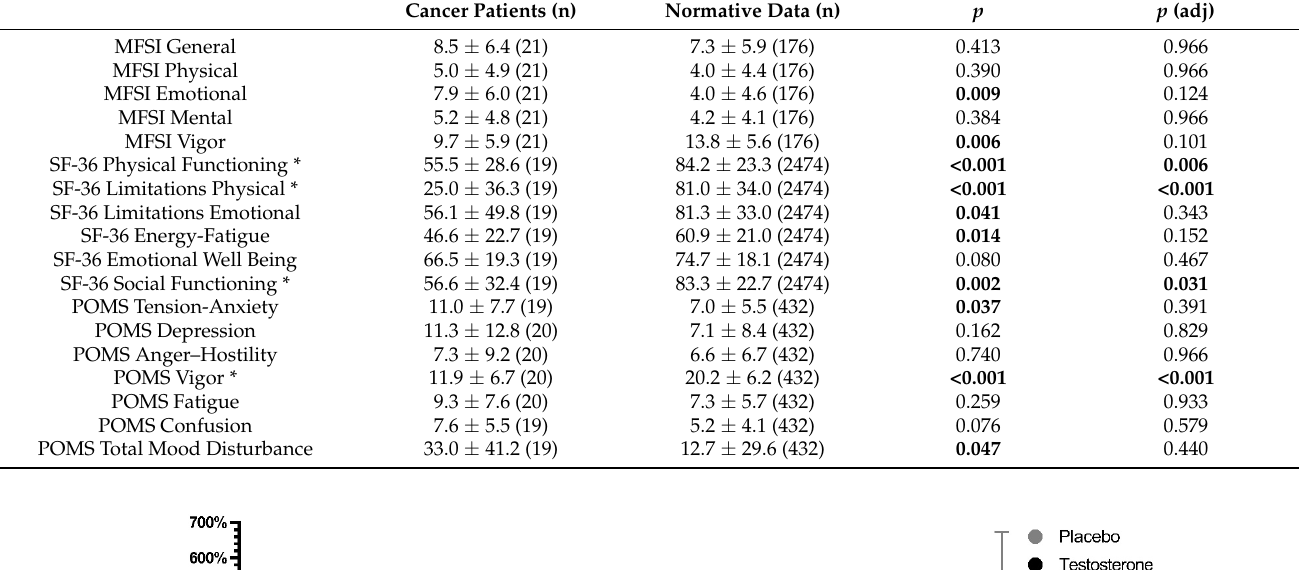
Table 2. Baseline MFSI, SF-36, and POMS scores (mean ± SD) for cervical or head and neck cancer patients compared to normative data. Questionnaire scores/subscales that were significantly different after correction for multiple testing are indicated with an asterisk. Normative data for MFSI, SF-36, and POMS questionnaires from Cordero et al., 2012, Nyenhuis et al., 1999, and Ware et al., 1993, respectively. MFSI—Multidimensional Fatigue Symptom Inventory—Short Form, SF-36—RAND 36-Item Health Survey 1.0, POMS—Profile of Mood States—Short Form.